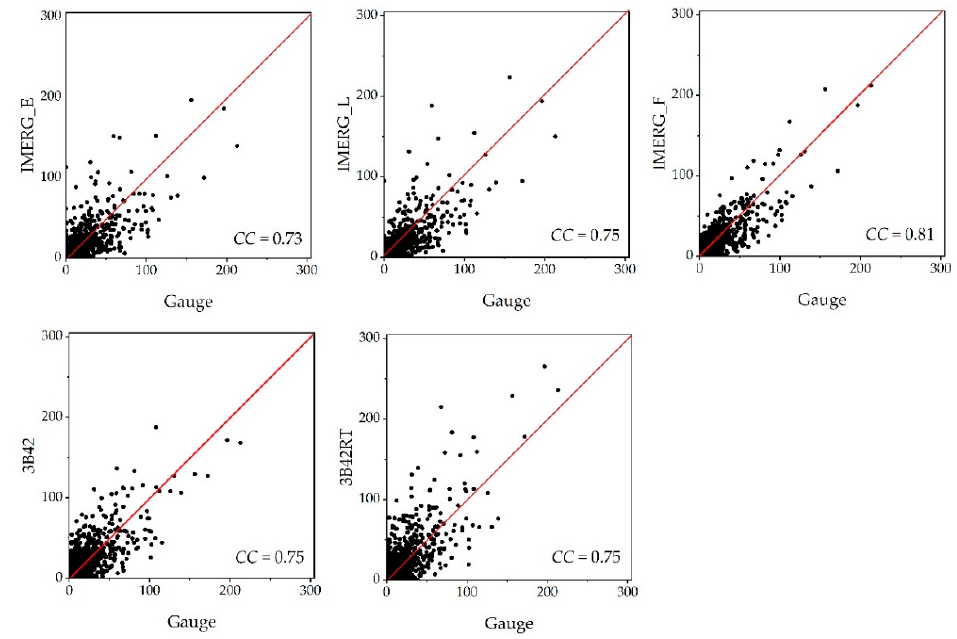
Figure A4. Scatterplots between daily rainfall gauge observations and satellite precipitation product estimates.